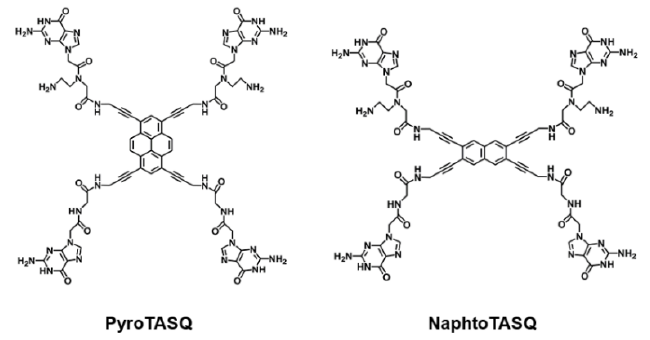
Figure 10. Chemical structures of PyroTASQ and NaphtoTASQ.